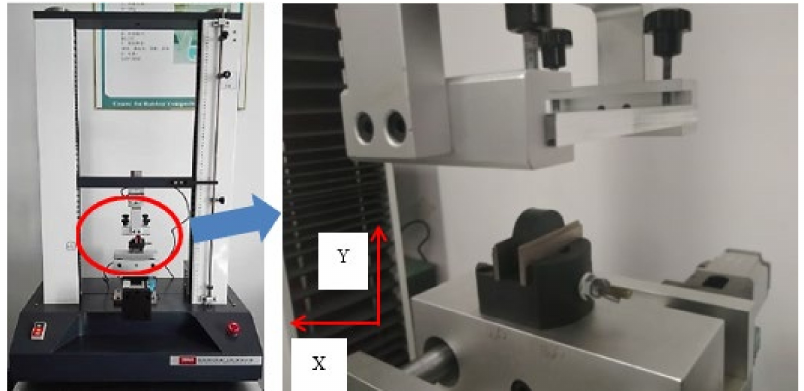
Figure 6. Friction